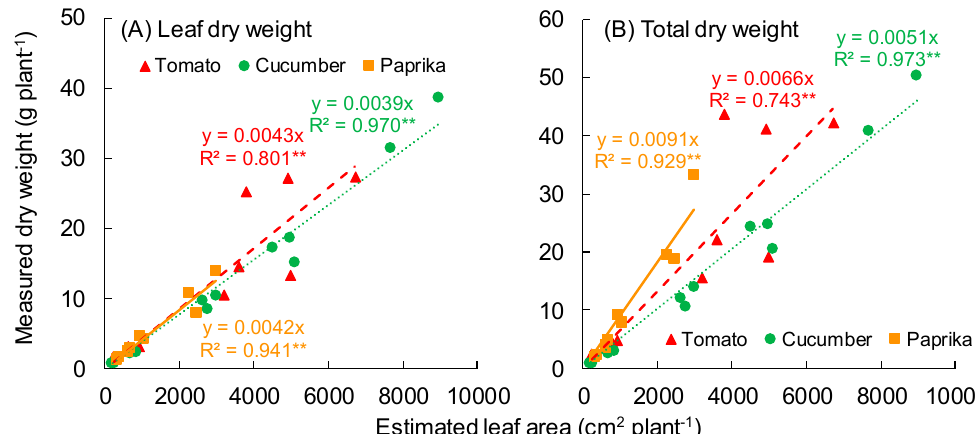
Figure 10. Relationship between estimated leaf area and measured dry weight (leaf or total). ( A ) and ( B ) show the dry weights of leaf and total, respectively. The total dry weight does not include fruit. The estimated leaf area is the area of polygons in the plant surface model. Tomato plants were scanned using the 3D scanner (DPI-8X, Opt Technologies Co., Ltd., Tokyo, Japan) from 5 April to 23 May 2019. Cucumber plants were scanned from 3 April to 23 May 2019. Paprika plants were scanned from 5 April to 2 August 2019. ** significant at p < 0.01 according to the regression analysis.